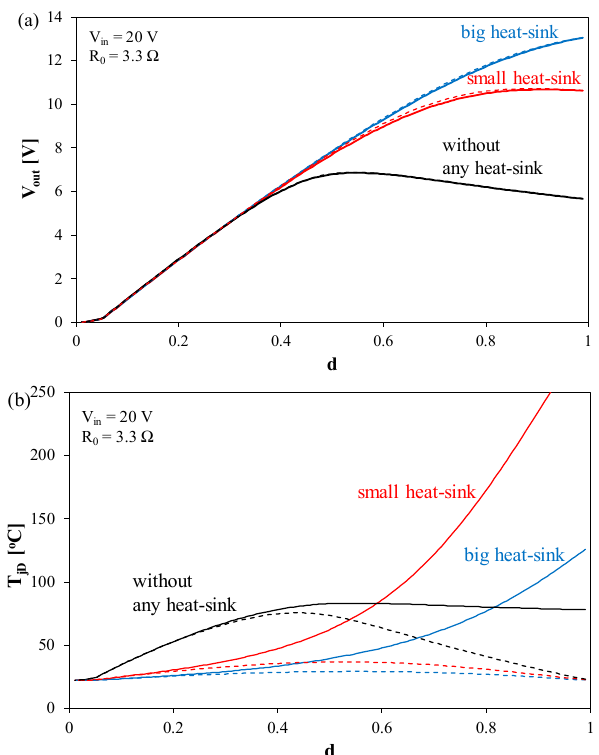
Figure 11. Computed waveforms of: ( a ) the boost converter output voltage at voltage V in of the form of a voltage step, ( b ) the transistor internal temperature.